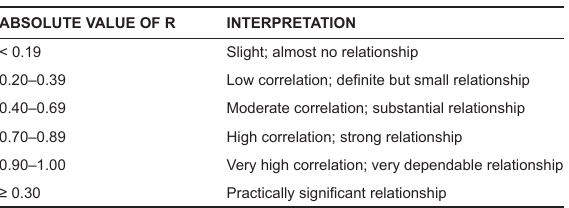
TABLE 1 Guilford’s interpretation of the magnitude of significant correlations